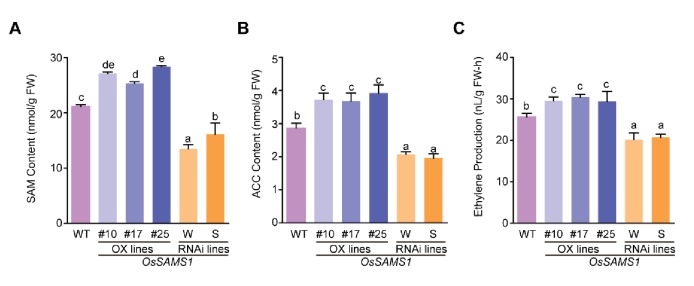
SAM, ACC and ethylene contents in OsSAMS1 transgenic lines.(A) SAM content in OsSAMS1 transgenic lines and WT plants (using 40-d-old seedlings). (B) ACC content in OsSAMS1 transgenic lines and WT plants (using 40-d-old seedlings). (C) Ethylene content in OsSAMS1 transgenic lines and WT plants (using 40-d-old seedlings). Tukey’s honestly significant difference post hoc tests were performed for multiple comparisons. Letters indicate significantly different results, p<0.05. Data are from three replicates. FW, fresh weight.